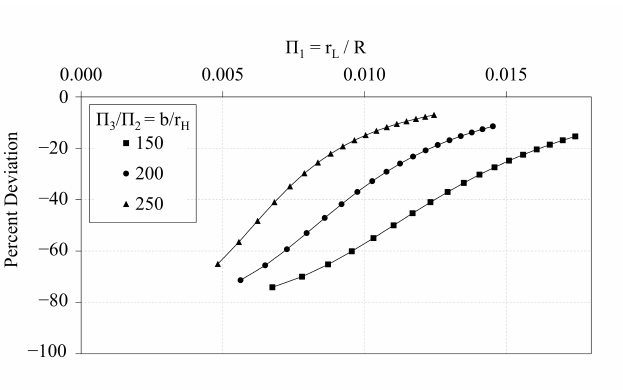
Figure 10. OLC Π 0 vs. Π 1 Percent deviation of analytical predictions from FE predictions [26].